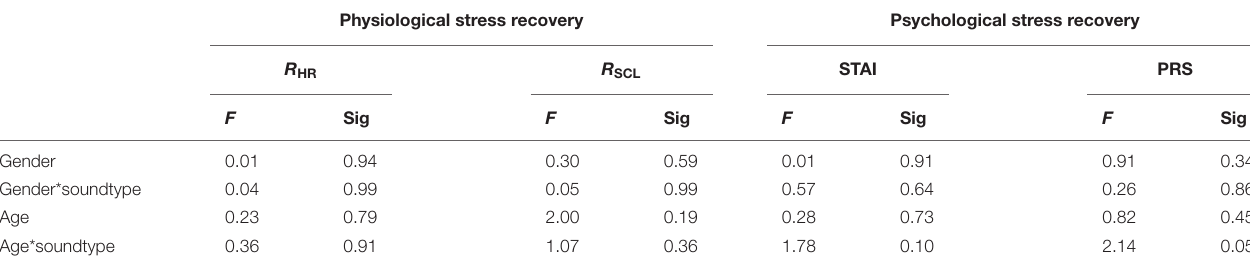
TABLE 3 | MANOVA results for main and interaction effects on physiological and psychological recovery. Physiological stress